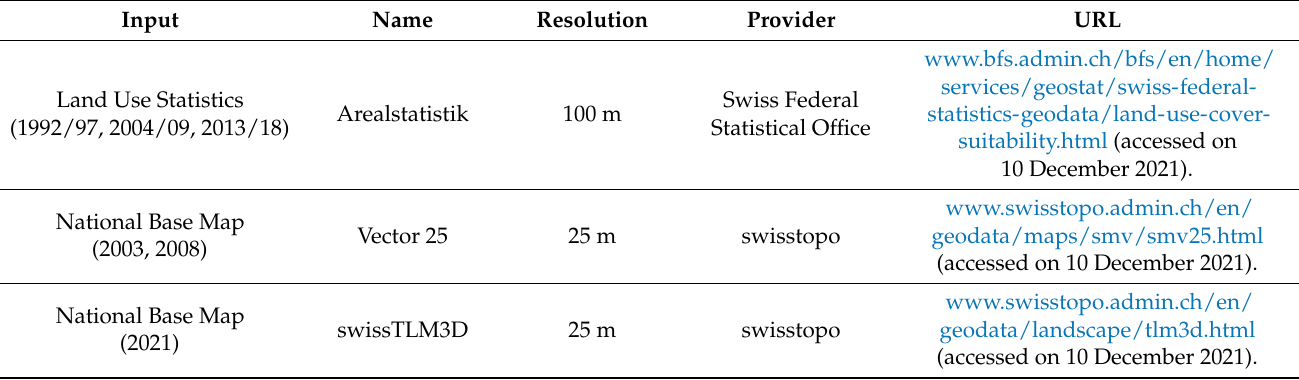
Table 1. Data input